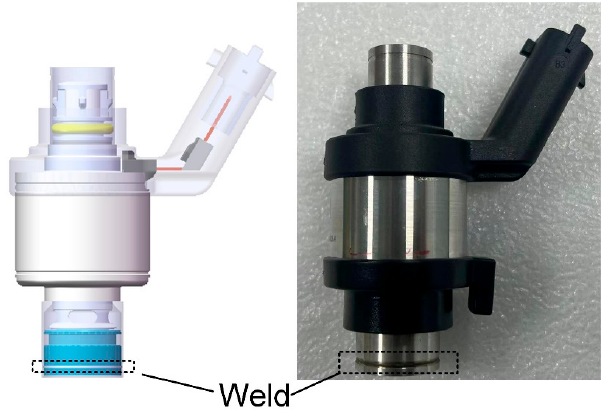
Table 1. Chemical composition of materials.